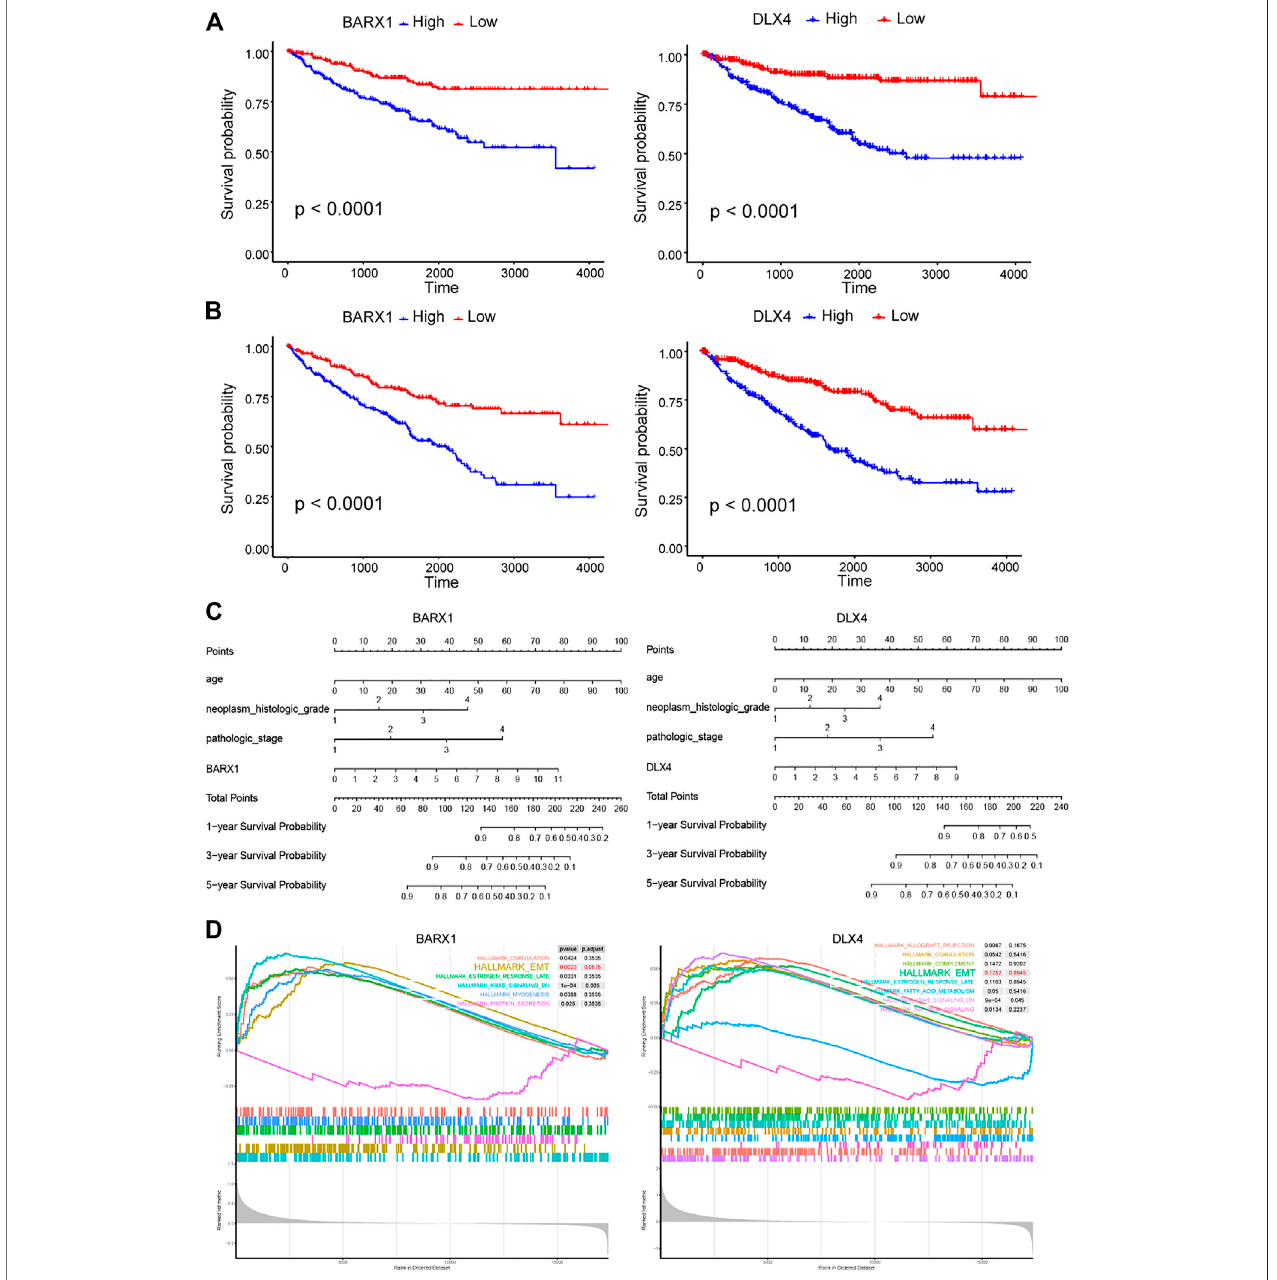
FIGURE 5 | BARX1 and DLX4 predict poor prognosis in ccRCC and may promote epithelial – mesenchymal transition (EMT). (A) In the TCGA KIRC cohort, BARX1 and DLX4highly expressed patientshave poorerdisease-speci fi csurvival(DSS). (B) IntheTCGA KIRCcohort, BARX1and DLX4highly expressed patientshave poorer overall survival (OS). (C) The prognostic nomogram of BARX1 or DLX4 for OS at 1, 3, and 5 years. (D) The gene set enrichment analysis (GSEA) of hallmark gene sets in the high-expression group of BARX1 or